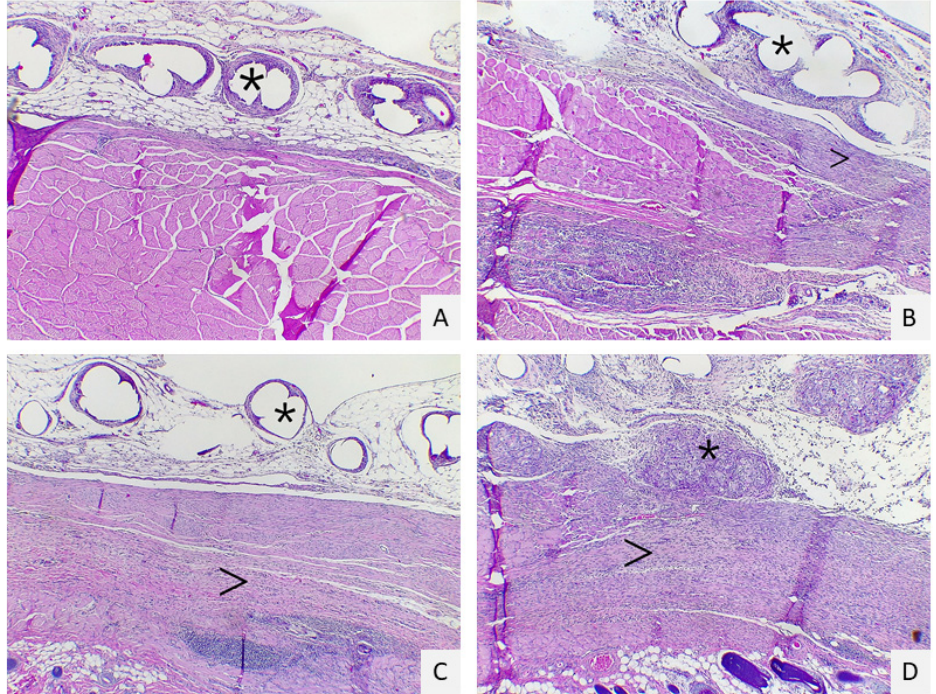
Figure 2. Histological scores of inflammation: score 1 ( A ): multifocal granulomas (asterisk) in adipose tissue with low interstitial fibroplasia (arrow); score 2 ( B ): multifocal granulomas with a moderate amount of fibroplasia score 3 ( C ): multifocal to coalescent granulomas with a moderate amount of fibroplasia; score 4 ( D ): multifocal to coalescent granulomas with a severe amount of interstitial fibroplasia Hematoxylin-eosin staining; magnification: 4 ×